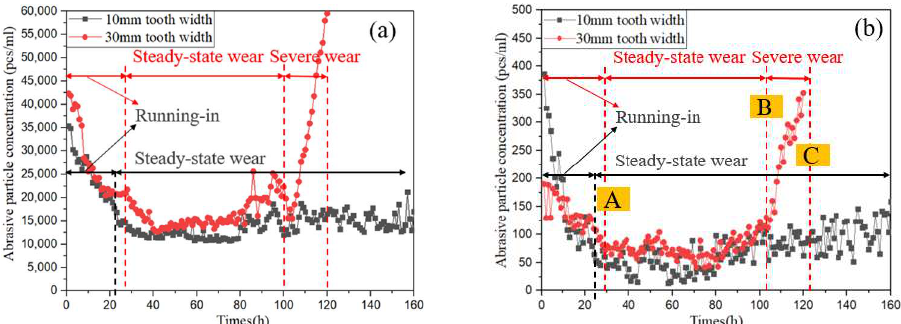
Figure 7. Variation trend of abrasive particle concentration ( a ) 5–50 µ m abrasive particle concentration; ( b ) 50–100 µ m abrasive particle concentration.